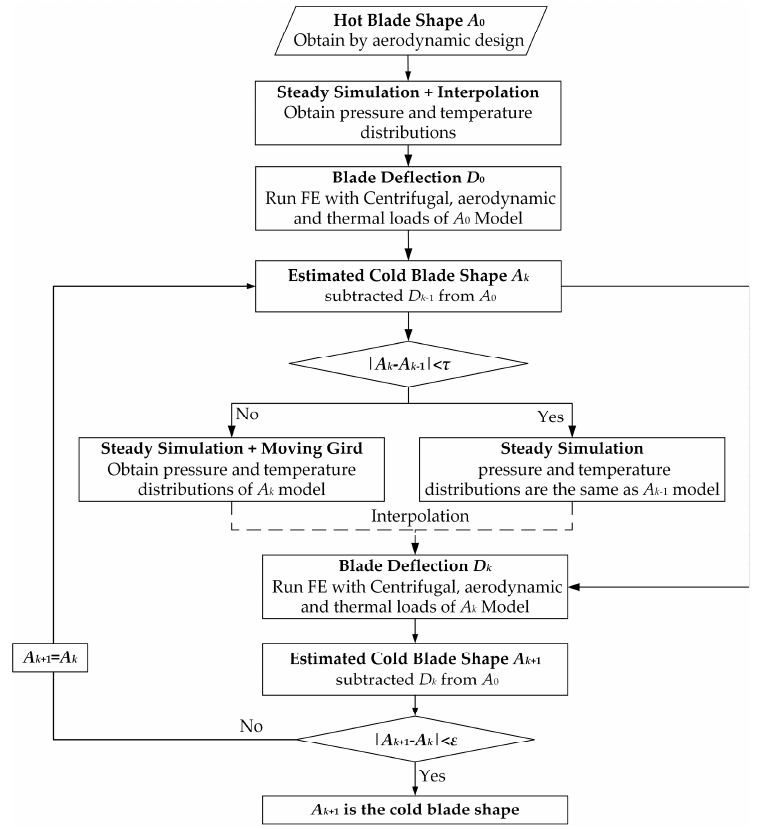
Figure 9. Flow chart of SWCS method.